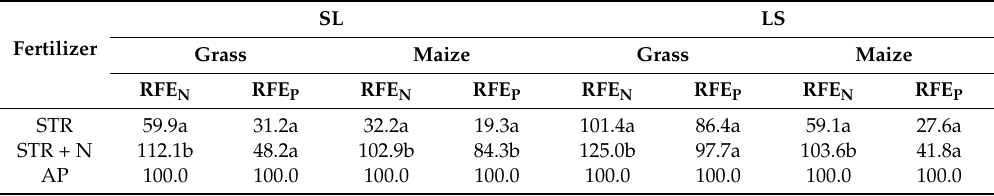
Table 1. The related fertilizer efficiency (%) of STR and STR + N.